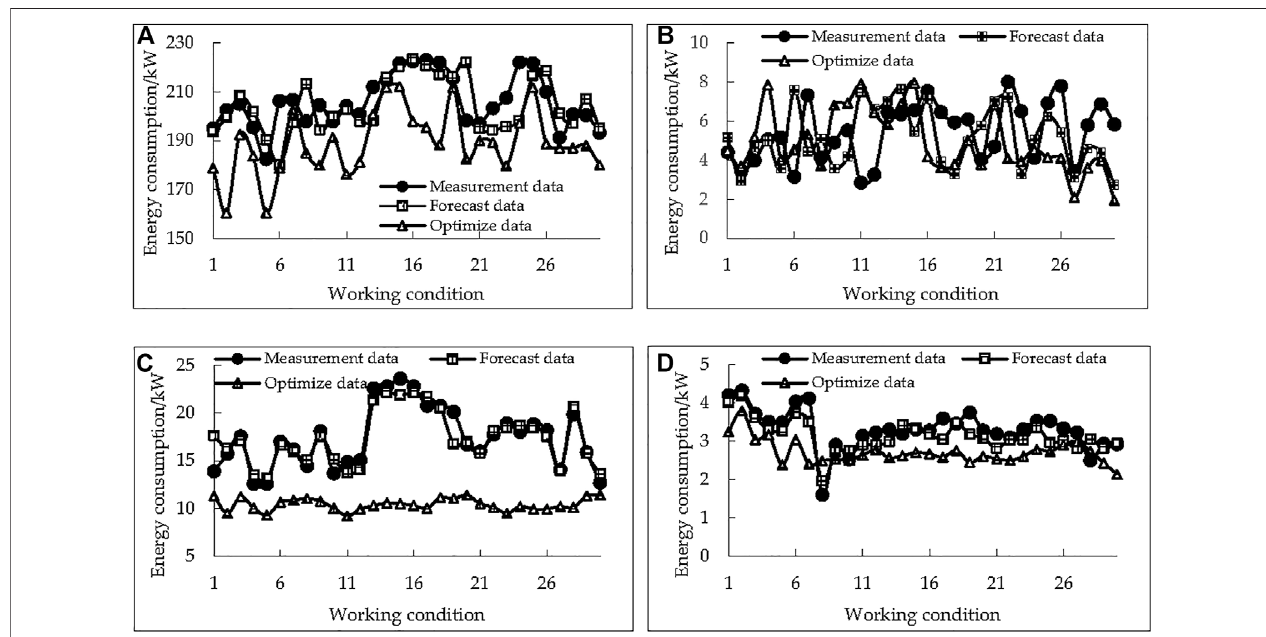
FIGURE 11 | Equipment energy consumption before and after optimization. (A) Optimized, predicted and actual energy consumption data for the cooling mainframe; (B) Optimized, predicted and actual energy consumption data for chilled water pump; (C) Optimized, predicted and actual energy consumption data for cooling water pump; (D) Optimized, pre dicted and actual energy consumption data for cooling tower.